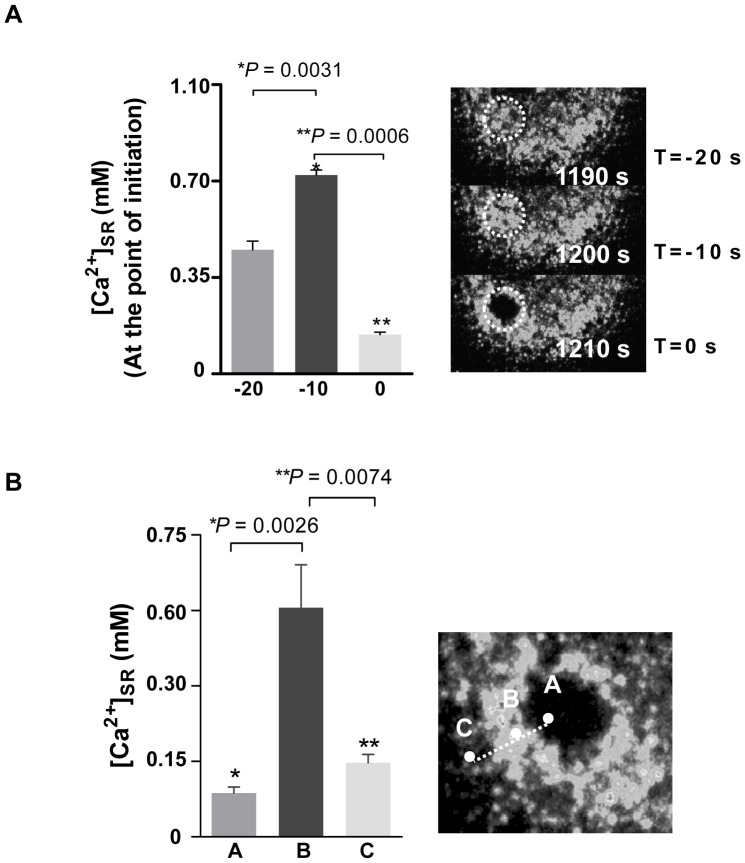
Characteristics of the ET-1-induced Ca2+ depletion waves.
A) Average changes in Ca2+ signal intensity at the points of initiation. T = 0, T = −10 s, and T = −20 s refer to the time when the depletion wave first appears and 10 and 20 s prior to wave initiation, respectively. The Ca2+ signal significantly increases at T = −10 s, and drops to a low level as the waves initiate at T = 0 s (n = 5 cells from five independent experiments, mean ± SEM, *P = 0.0031, **P = 0.0006). B)
R/R0 values in three regions of the depletion wave (A: already depleted area; B: area that has taken up released Ca2+; C: area not yet affected by the wave B). At any given time point, the signal intensity at the rim (point B) is higher than both the already depleted area (point A) and the adjacent SR locus ahead of the wave (point C) (ROI = 4, n = 5 independent experiments, mean ± SEM, *P = 0.0026, **P = 0.0074).